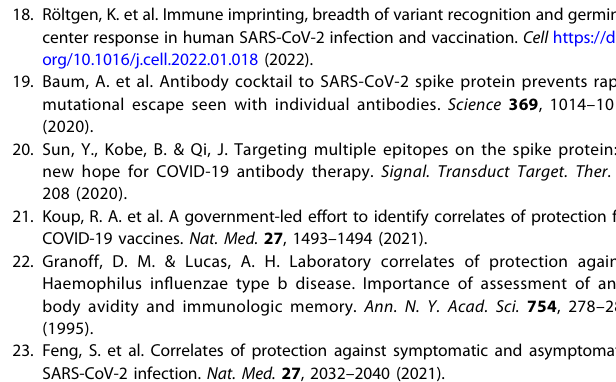
Fig. 1 Serotype escape or Af fi nity escape. Top: Neutralization of wildtype virus by pre-existing antibodies that block RBD binding to the receptor on the surface of susceptible host cells. Bottom left: RBD mutations may alter B cell epitopes such that pre-existing antibodies can no longer neutralize ( “ Serotype escape ” ). Bottom right: Alternatively, immune escape may occur because RBD af fi nity has increased to the extent that the binding of pre-existing antibodies is too weak for competing with RBD-receptor binding. Therefore, the antibodies are unable to neutralize the virus ( “ Af fi nity escape ” ). RBD, receptor binding